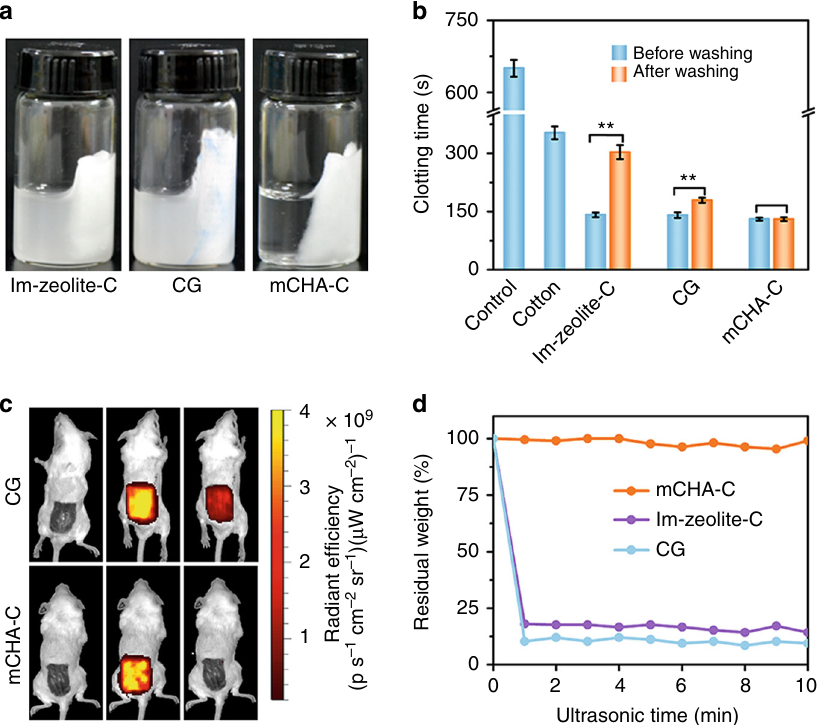
Fig. 3 Binding strength of hemostatic component and matrix. a Photograph of Im-zeolite-C, CG, and mCHA-C after soaking into water. b Plasma clotting time of hemostats before and after washing with deionized water. Source data are provided as a Source Data fi le. Data values corresponded to mean ± standard deviation (SD), n = 3. Error bars represent SD. ** P < 0.01, one-way analysis of variance (ANOVA). c Fluorescence imaging of mice skin wound before (left), during (mid), and after (right) being treated with Cy5-labeled mCHA-C and CG, respectively. d The relative residual weight of hemostatic component on mCHA-C (orange), Im-zeolite-C (violet), CG (turquoise) after different ultrasonic time. Source data are provided as a Source Data fi le NATURE COMMUNICATIONS| (2019) 10:1932